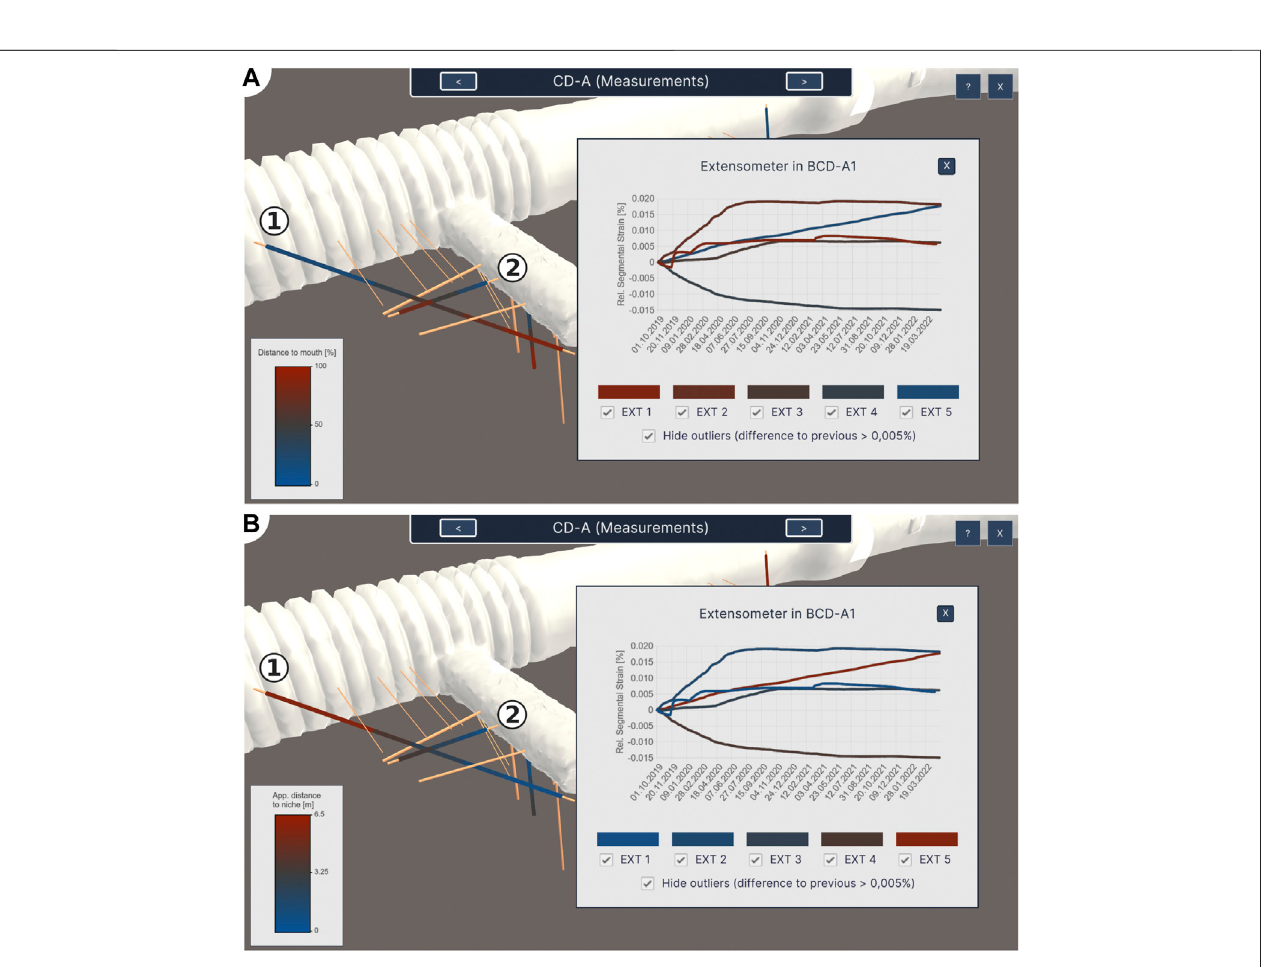
Frontiers in Earth Science |